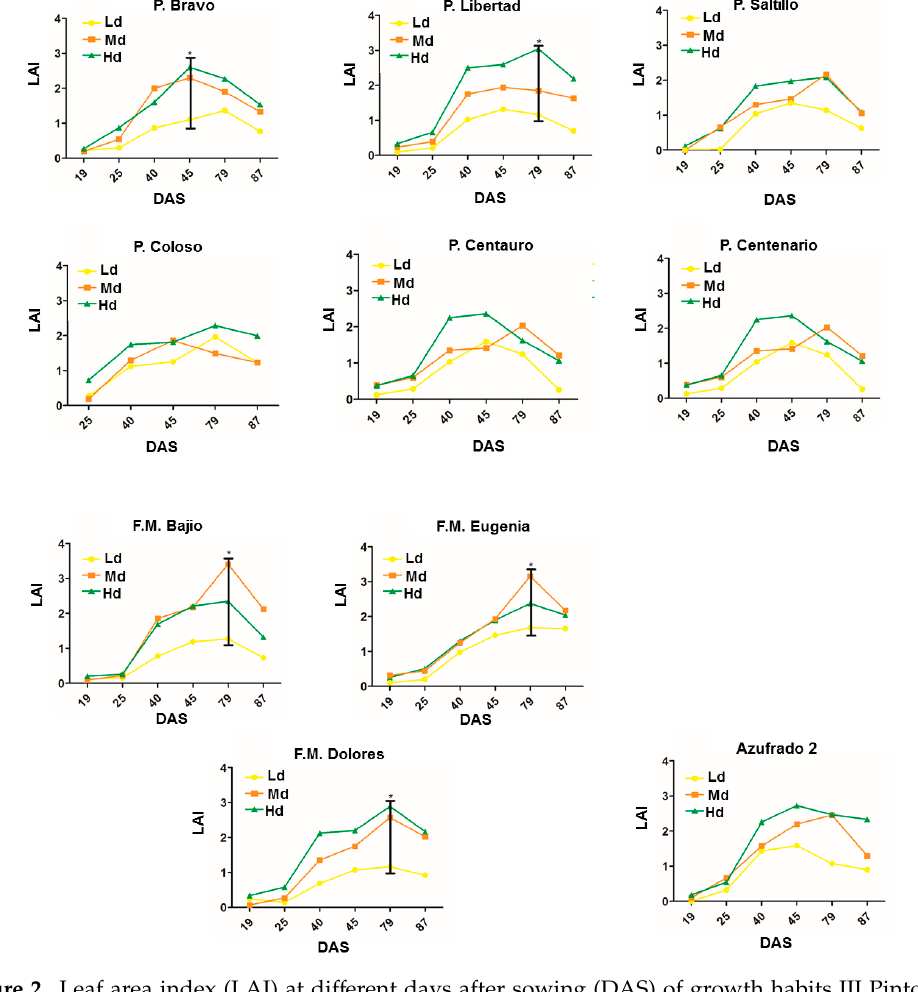
Figure 2. Leaf area index (LAI) at different days after sowing (DAS) of growth habits III Pinto (P) and Flor de Mayo (F.M.) and growth habit I Azufrado 2 dry bean ( Phaseolus vulgaris L.) cultivars established at 90,000 plants ha − 1 (Low density, Ld), 145,000 plants ha − 1 (Medium density, Md) and 260,000 plants ha − 1 (High density, Hd) under rainfed conditions in Pabellon de Arteaga, Aguascalientes, Mexico during the 2011 growing season.